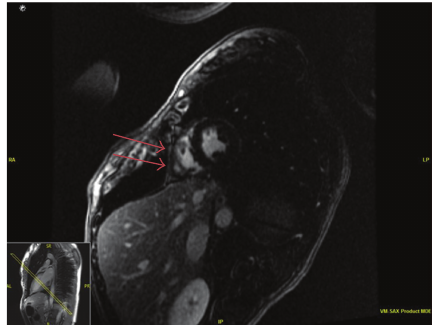
Figure 1: Acute onset saddle nose deformity due to inflammation of the nasal cartilage demonstrated six weeks following symptom onset.